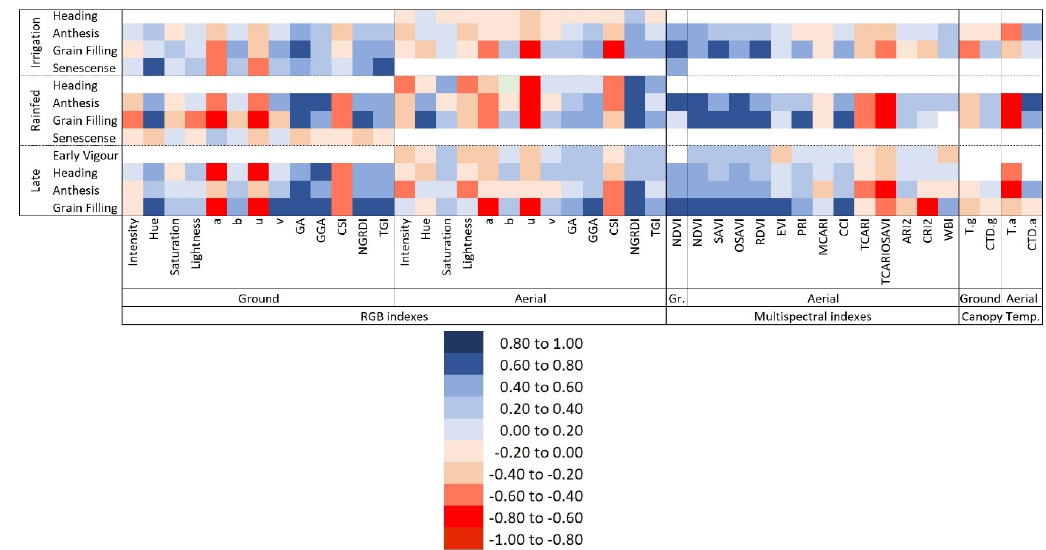
Figure 3. Pearson correlation coefficient heatmap of grain yield with parameters measured from ground and aerial platforms throughout the different phenological stages and treatments. Correlations are scaled according to the key above. Correlations were studied across the 72 plots from each growing